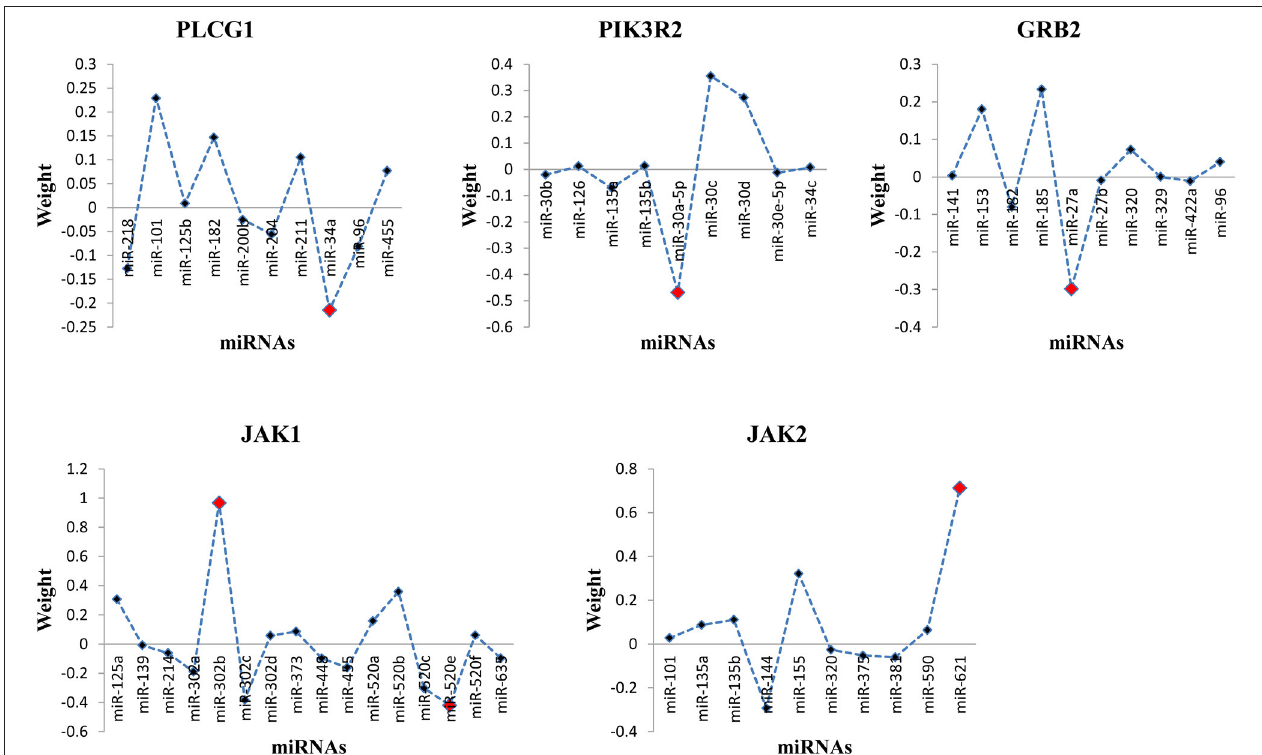
FIGURE 2 | Distribution of miRNA weights for the target mRNAs in the SVR model. The red dot indicated the best weighted